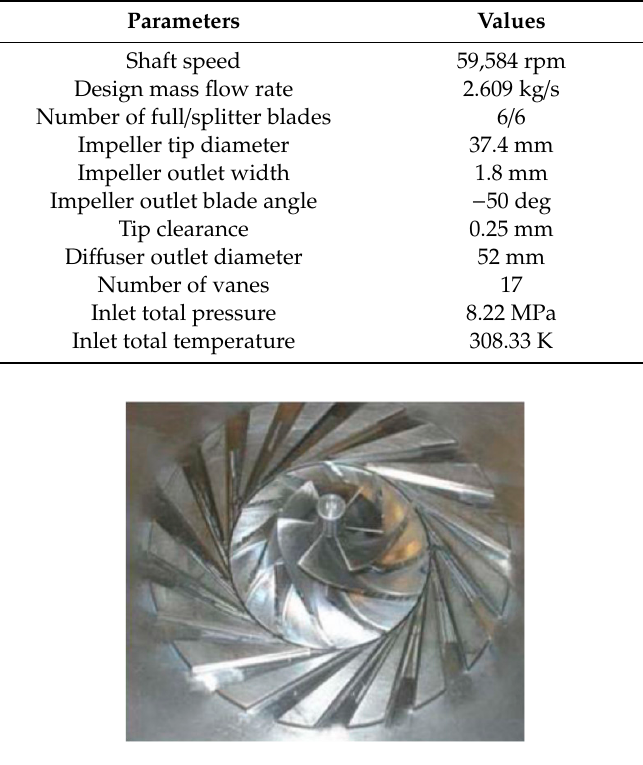
Figure 2. Solid model of the Sandia SCO 2 compressor.